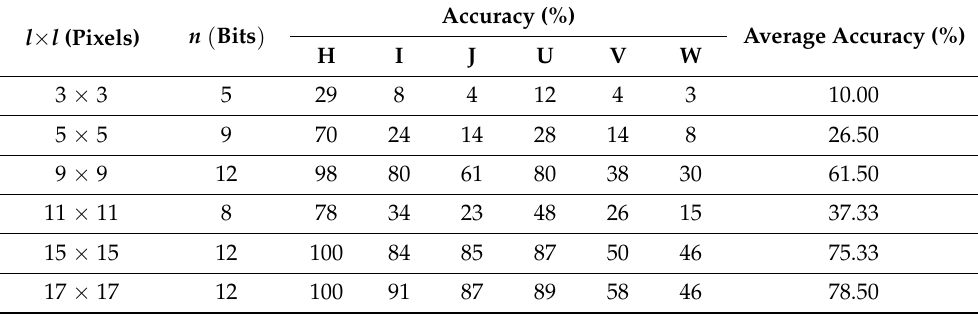
Table 2. Comparison of the results obtained using six BSIF configurations with occlusion by sunglasses.